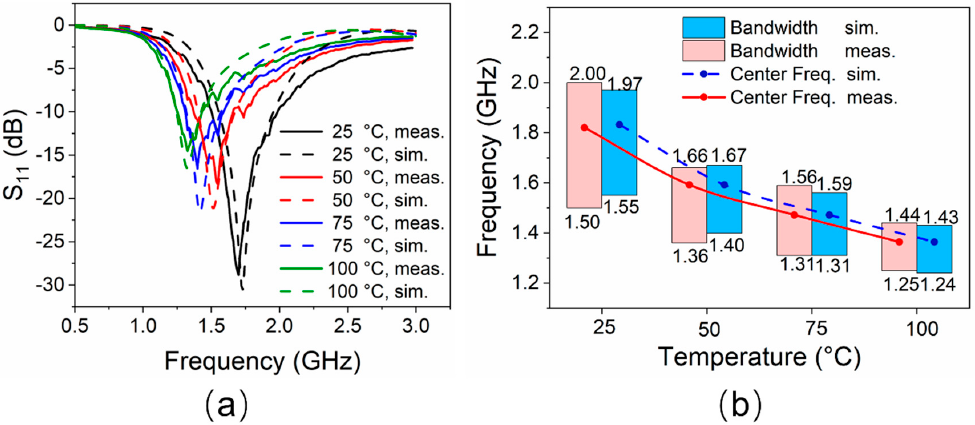
Figure 6. ( a ) Reflection coefficients of the antenna at different temperatures. ( b ) Impedance band- widths performance of the antenna at different temperatures.